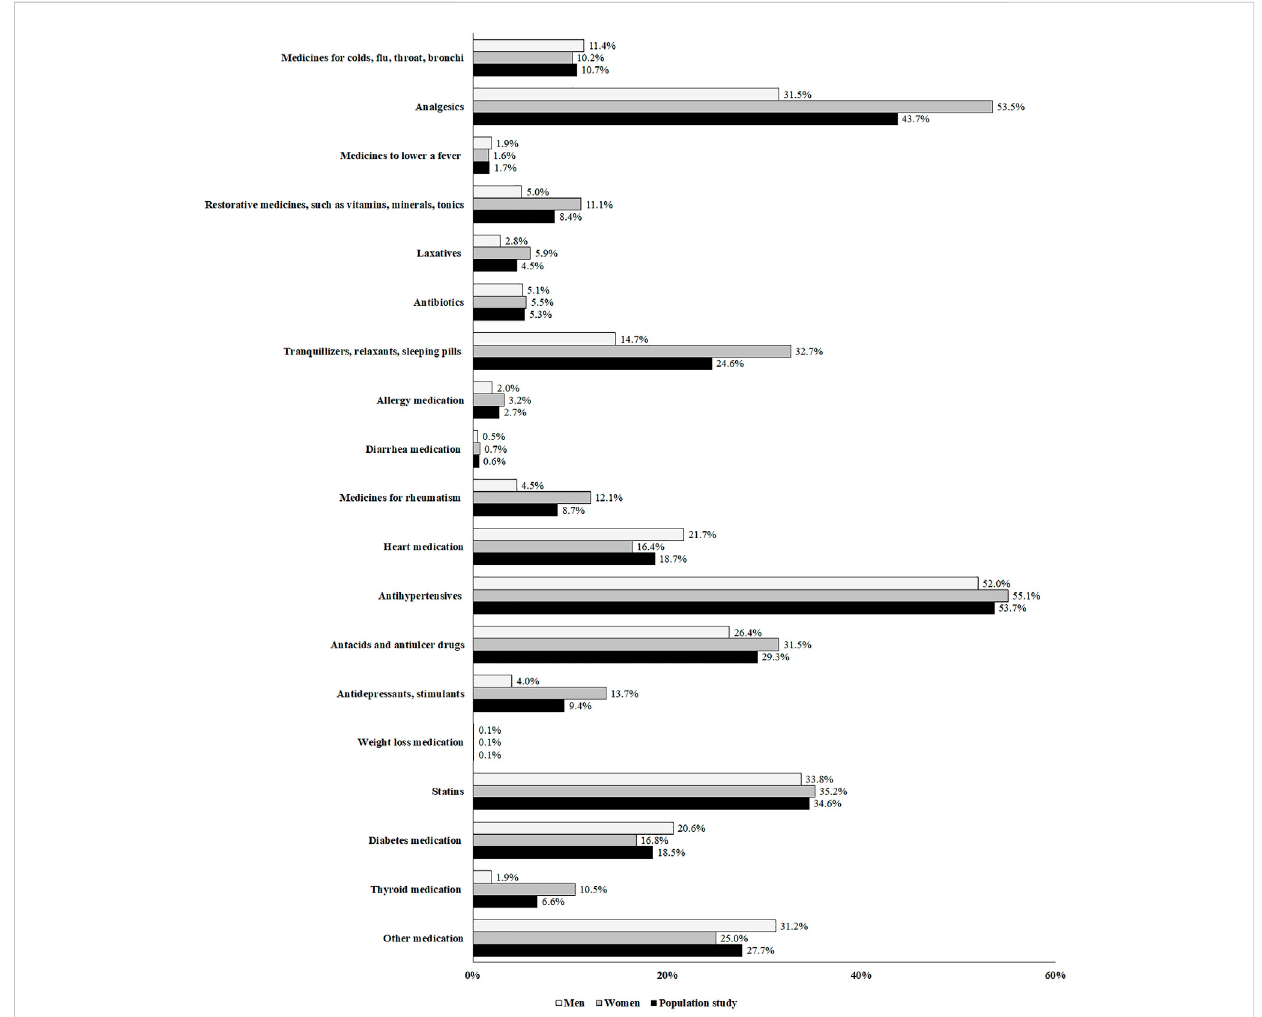
FIGURE 3 Distribution of medicine use in adults ≥ 65 years in the population study ( N =